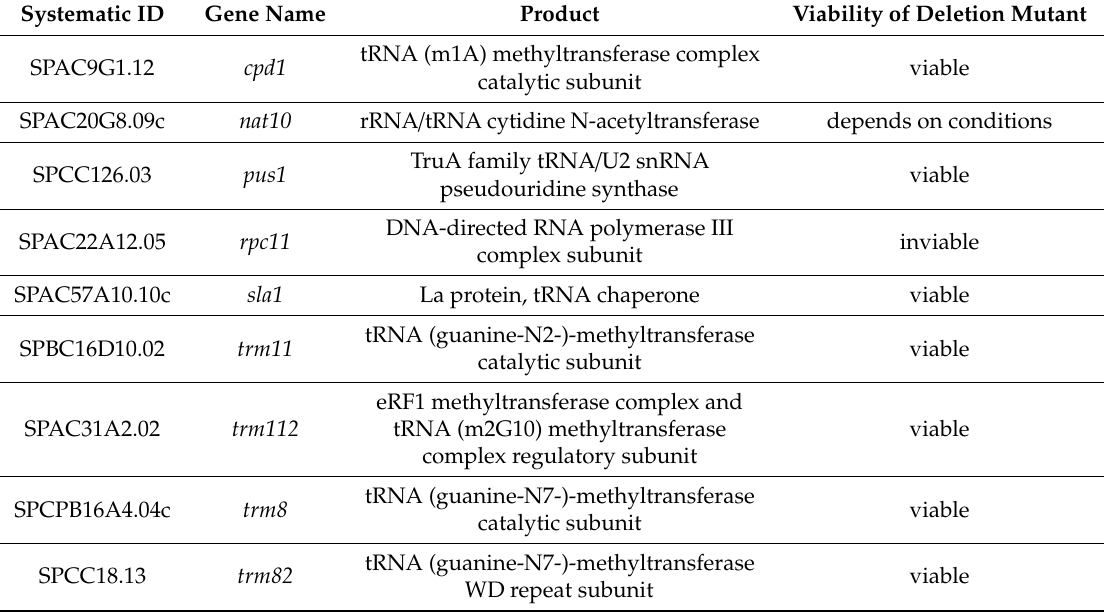
Table 3. tRNA-related S. pombe genes downregulated more than three-fold after treatment with rapamycin and caffeine.